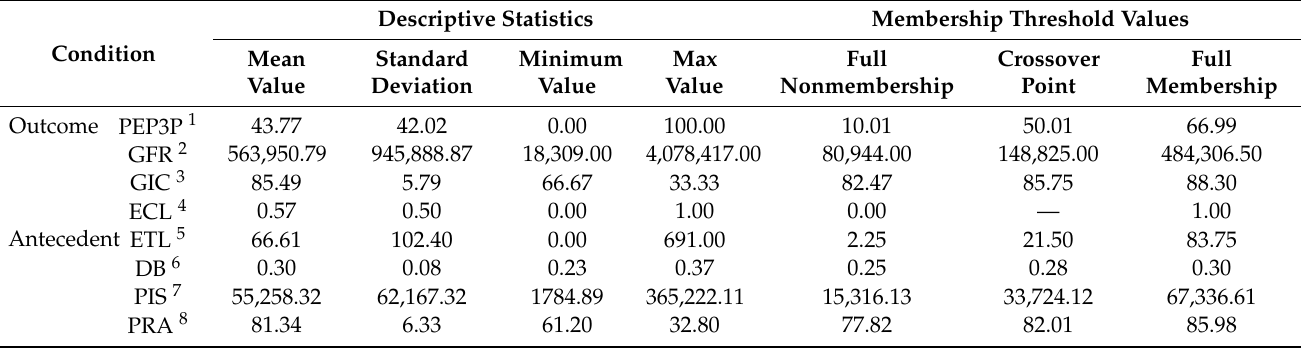
Table 1. Calibration and descriptive statistics of the outcome and the antecedent